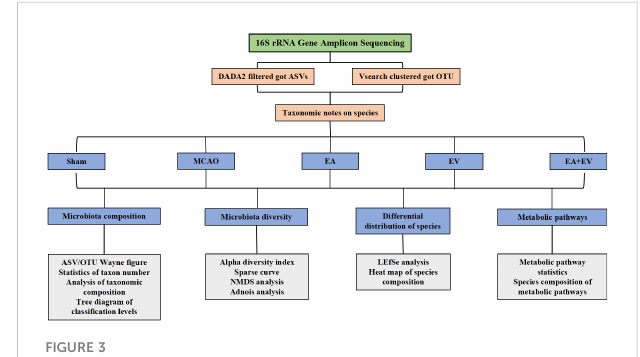
FIGURE 3 16S rRNA gene amplicon sequencing bioinformatics and statistical